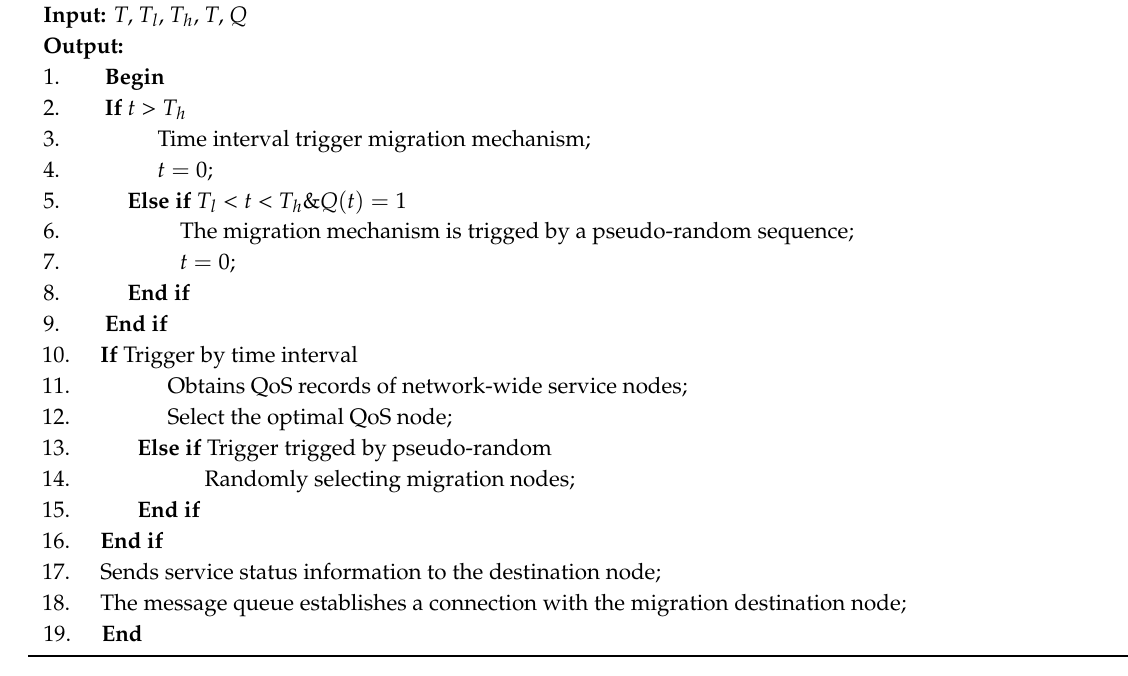
Table 2. The experimental PC hardware configuration.